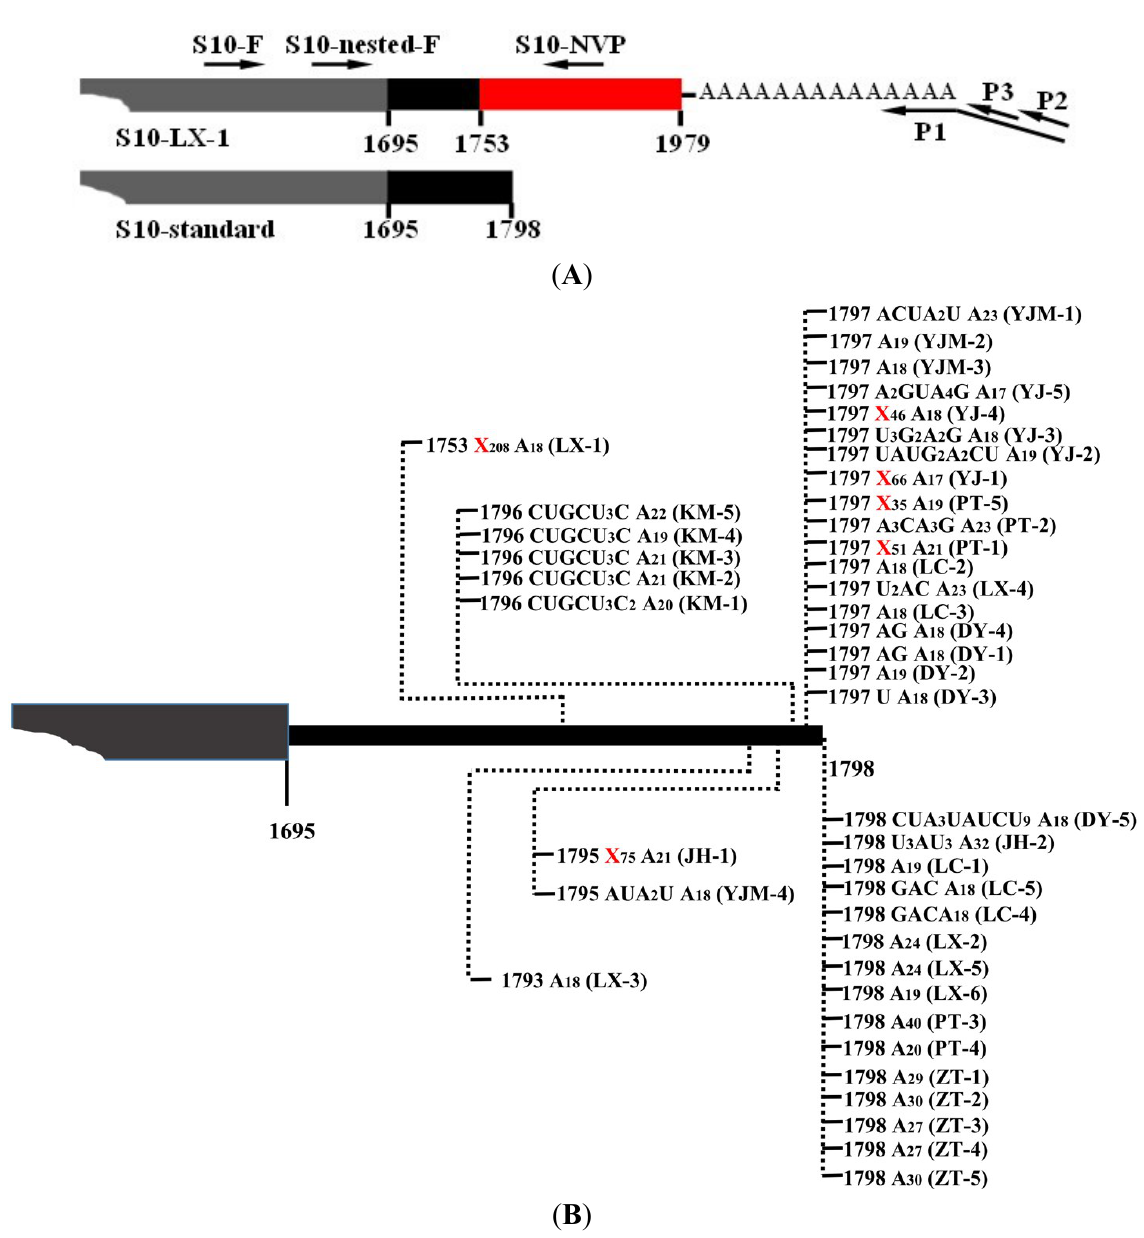
Figure 1. The 3' Rapid Amplification of cDNA End (RACE) detection of the polyadenylated southern rice black-streaked dwarf virus (SRBSDV) S10-mRNA. ( A ) Schematic diagram of the primers in S10-mRNA. The primers are displayed as arrowheads (Table 1), and the gray box, black box and red box indicate respectively partial ORF, 3' UTR and non-viral nucleotides in S10-mRNA. ( B ) Nature of 3' polyadenylate tails associated with S10-mRNA in plant. The poly(A) and poly(A)-rich tails of S10-mRNA are schematically presented, and vertical dashed lines with numbers indicate the exact positions of polyadenylate tails. Nucleotide compositions of the tails are shown, and long non-viral nucleotides are shown with X n . Isolate names in parentheses, DY: Duyun, PT: Pingtang, Guizhou province; JH: Jianghua, Hunan province; KM: Kunming, LC: Longchuan, YJ (YJM): Yingjiang, ZT: Zhaotong, Yunnan province; LX: Luxi, Jiangxi province. The number after abbreviation is the numbering of isolate clones. YJM isolates are from maize, and others are from